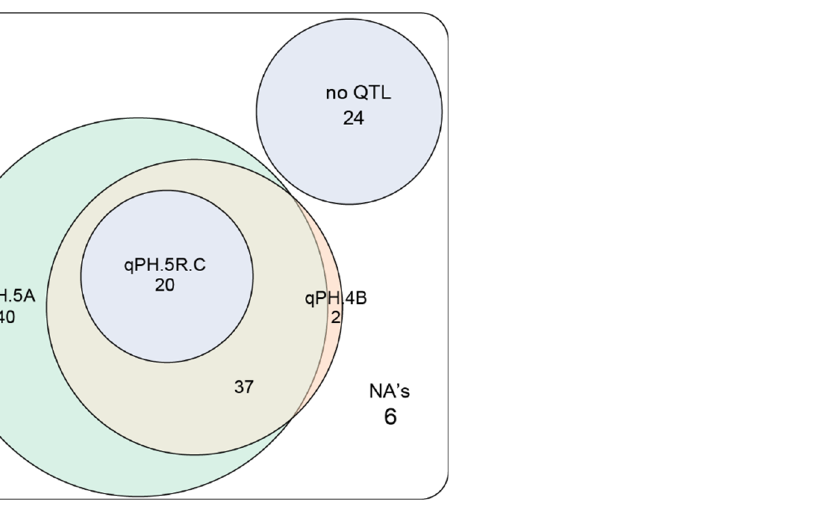
Figure 5. Number of cultivars with one or a combination of the plant height-reducing alleles at the detected QTL.